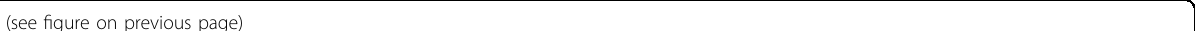
Fig. 6 IRS1 condensates produced PIP3 and recruited PKB in response to insulin. a Time-series imaging of IRS1-GFP and PIP3 sensor in U2OS cells upon insulin stimulation. The merged images of IRS1-GFP and PIP3 sensor were enlarged and shown in the upper left corners. Scale bar, 10 μ m. b Cellular localization of endogenous IRS1 and p85 in U2OS cells in response to insulin stimulation. The IRS1 puncta co-localized with p85 were indicated with white arrows. The p85 antibody was labeled with Alexa564. Scale bar, 10 μ m. c Cellular localization of endogenous IRS1 and PIP2 sensor in U2OS cells in response to insulin stimulation. The IRS1 puncta co-localized with PIP2 sensor were indicated with white arrows. Scale bar, 10 μ m. d Cellular localization of endogenous IRS1 and PIP3 sensor in U2OS cells in response to insulin stimulation. The IRS1 puncta co-localized with PIP3 sensor were indicated with white arrows. Scale bar, 10 μ m. e Cellular localization of endogenous IRS1 and PKB β in U2OS cells in response to insulin stimulation. The IRS1 puncta co-localized with PKB β were indicated with white arrows. The IRS1 antibody was labeled with Alexa564. Scale bar, 10 μ m.